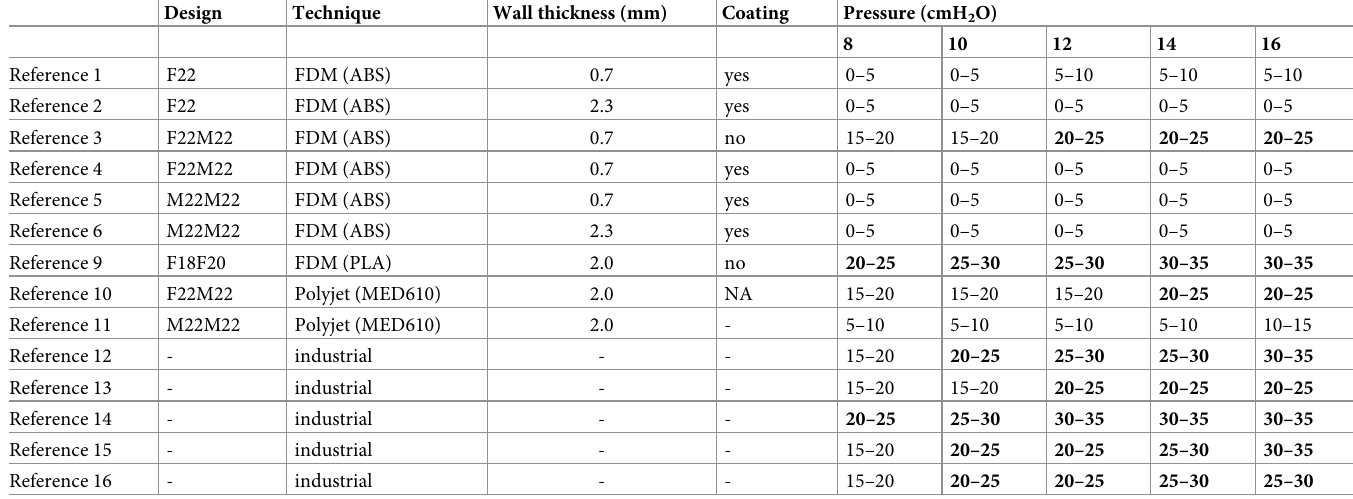
Table 3. Quantification of intentional leaks at 5 increasing pressure levels. References 7–8 have been excluded as T-fittings are not designed to produce intentional leaks. Bold characters: pressure values above 20 cmH 2 O.